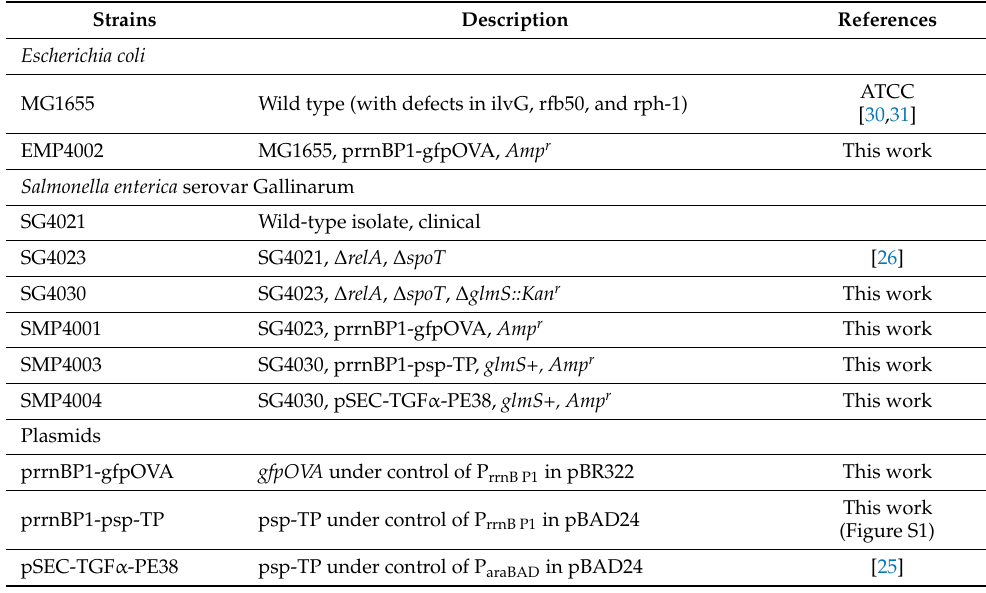
Table 1. Bacterial strains and plasmids used in this study.